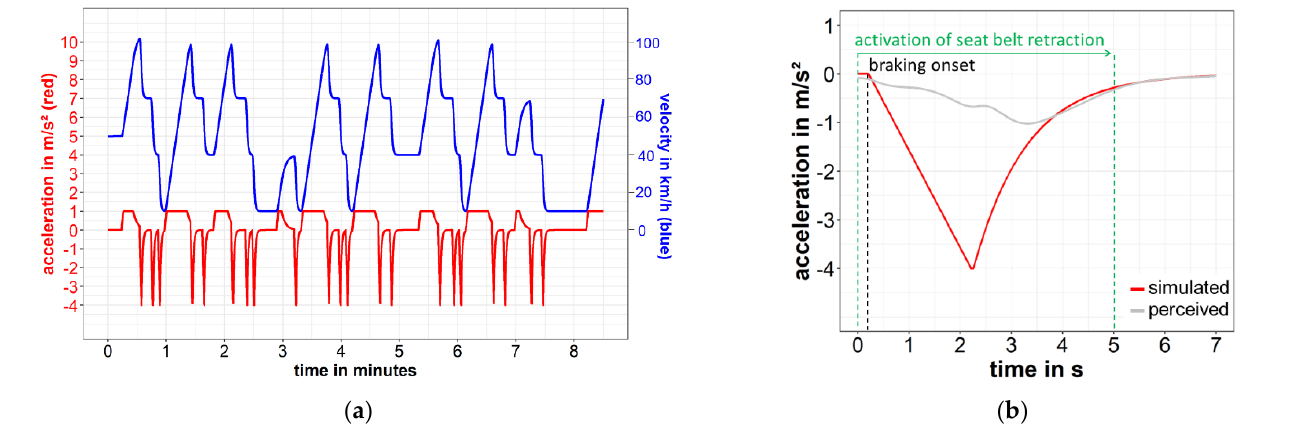
Figure 2. Illustration of the driving and braking profile: ( a ) First quarter of the implemented speed profile with the associated simulated accelerations; ( b ) Braking maneuver with a simulated minimum acceleration of −4 m/s 2 and a jerk of −2 m/s 3 , and a perceived minimum acceleration of −1 m/s 2 ; green: illustration of seat belt retraction activation 200 ms before braking onset and a holding time of 5 s.